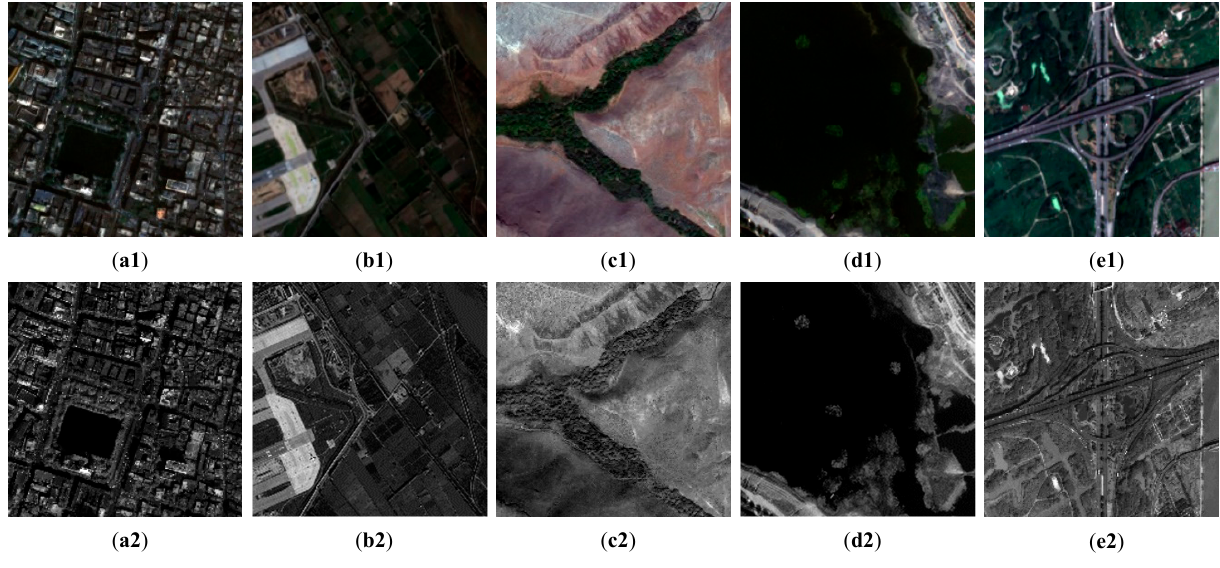
Figure 4. Five sets of multispectral image and panchromatic image. ( a1 ) PAN image of QuickBird; ( a2 ) MS image of QuickBird e; ( b1 ) PAN image of SPOT-6; ( b2 ) MS image of SPOT-6; ( c1 ) PAN image of WorldView-2; ( c2 ) MS image of WorldView-2; ( d1 ) PAN image of WorldView-3; ( d2 ) MS image of WorldView-3; ( e1 ) PAN image of Pleiades; ( e2 ) MS image of